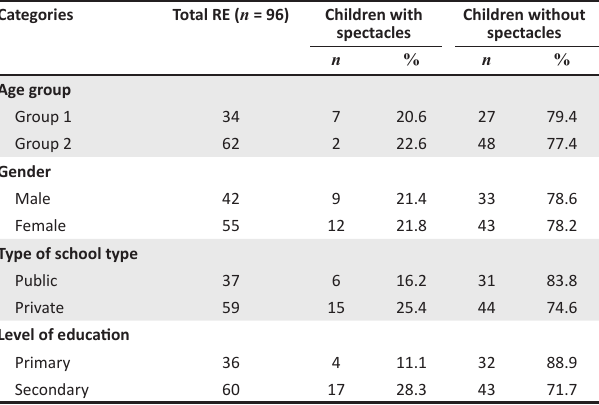
TABLE 3: Refractive error and spectacle use by age group, gender, type of school and level of education. Categories Children with